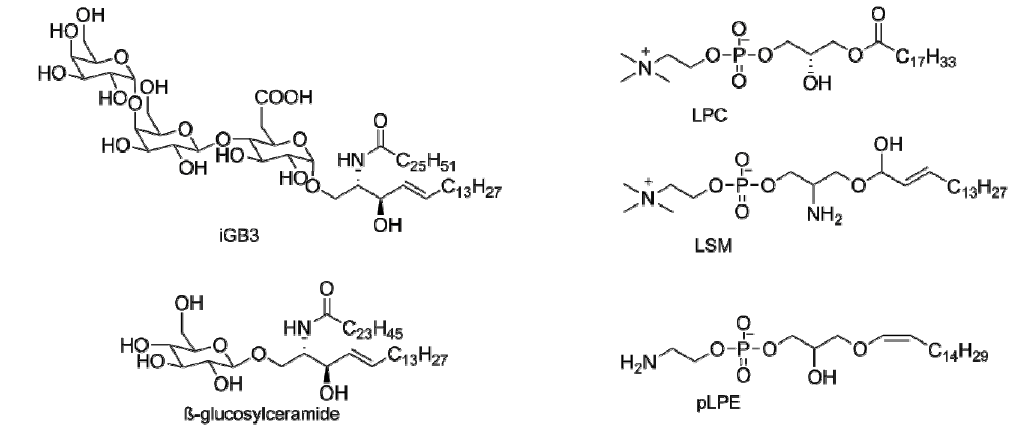
Figure 3. Proposed endogenous iNKT cell